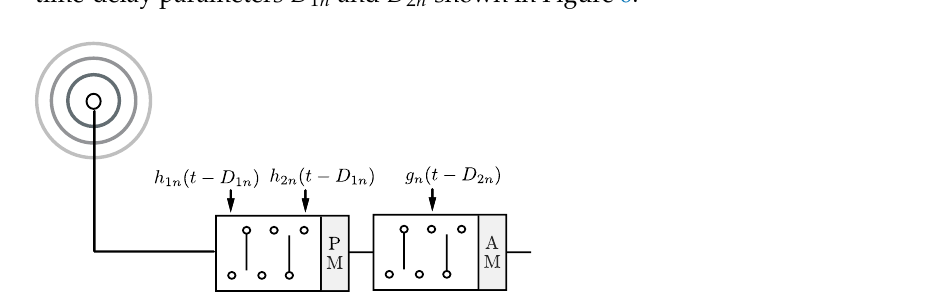
Figure 6. Block diagram of the n th element feeding network of the TMA approach that allows the independent steering of two harmonic beam patterns by combining AM and PM